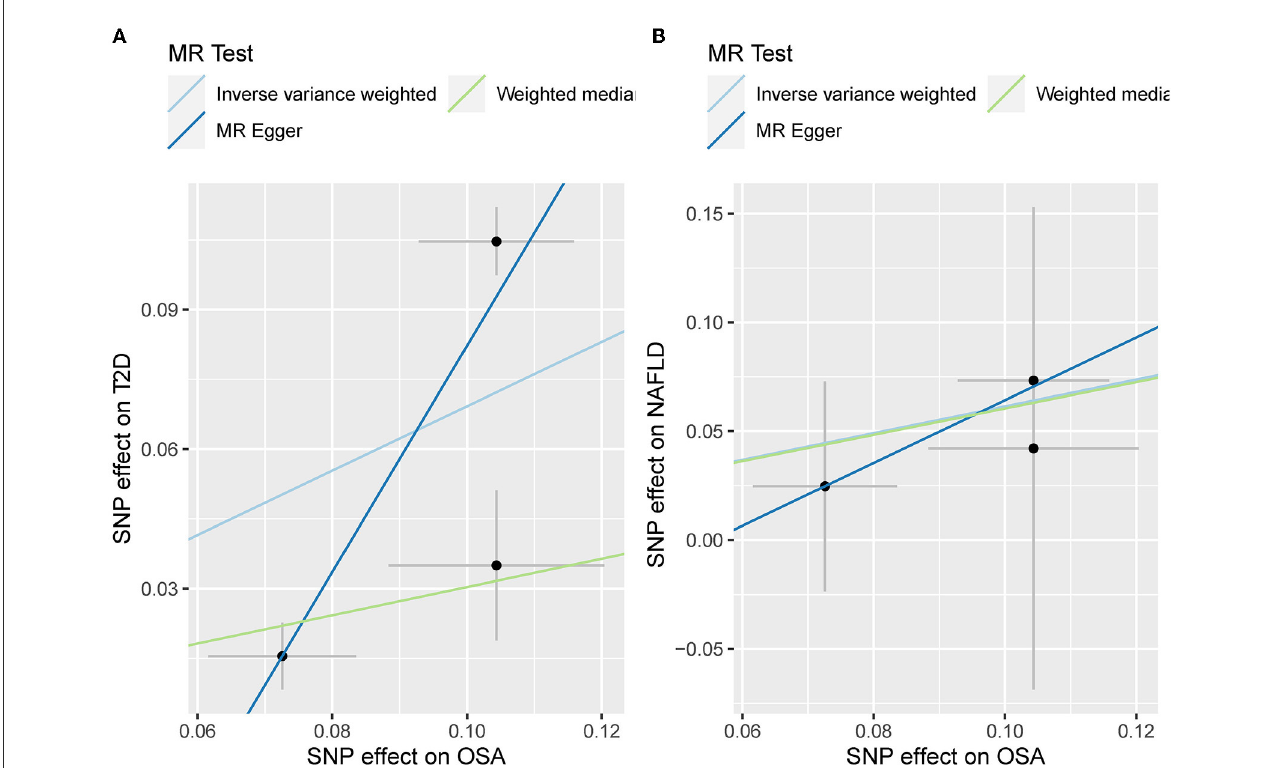
FIGURE6 (A) The scatterplot of OSA-T2D results after removal of SNP rs10928560. Different colors represent different methods and each point is a single nucleotide polymorphism. The horizontal and vertical lines of each point represent the 95% confidence interval of the effect size. (B) The scatterplot of OSA-NAFLD results after removal of SNP rs10928560. Different colors represent different methods and each point is a single nucleotide polymorphism. The horizontal and vertical lines of each point represent the 95% confidence interval of the effect